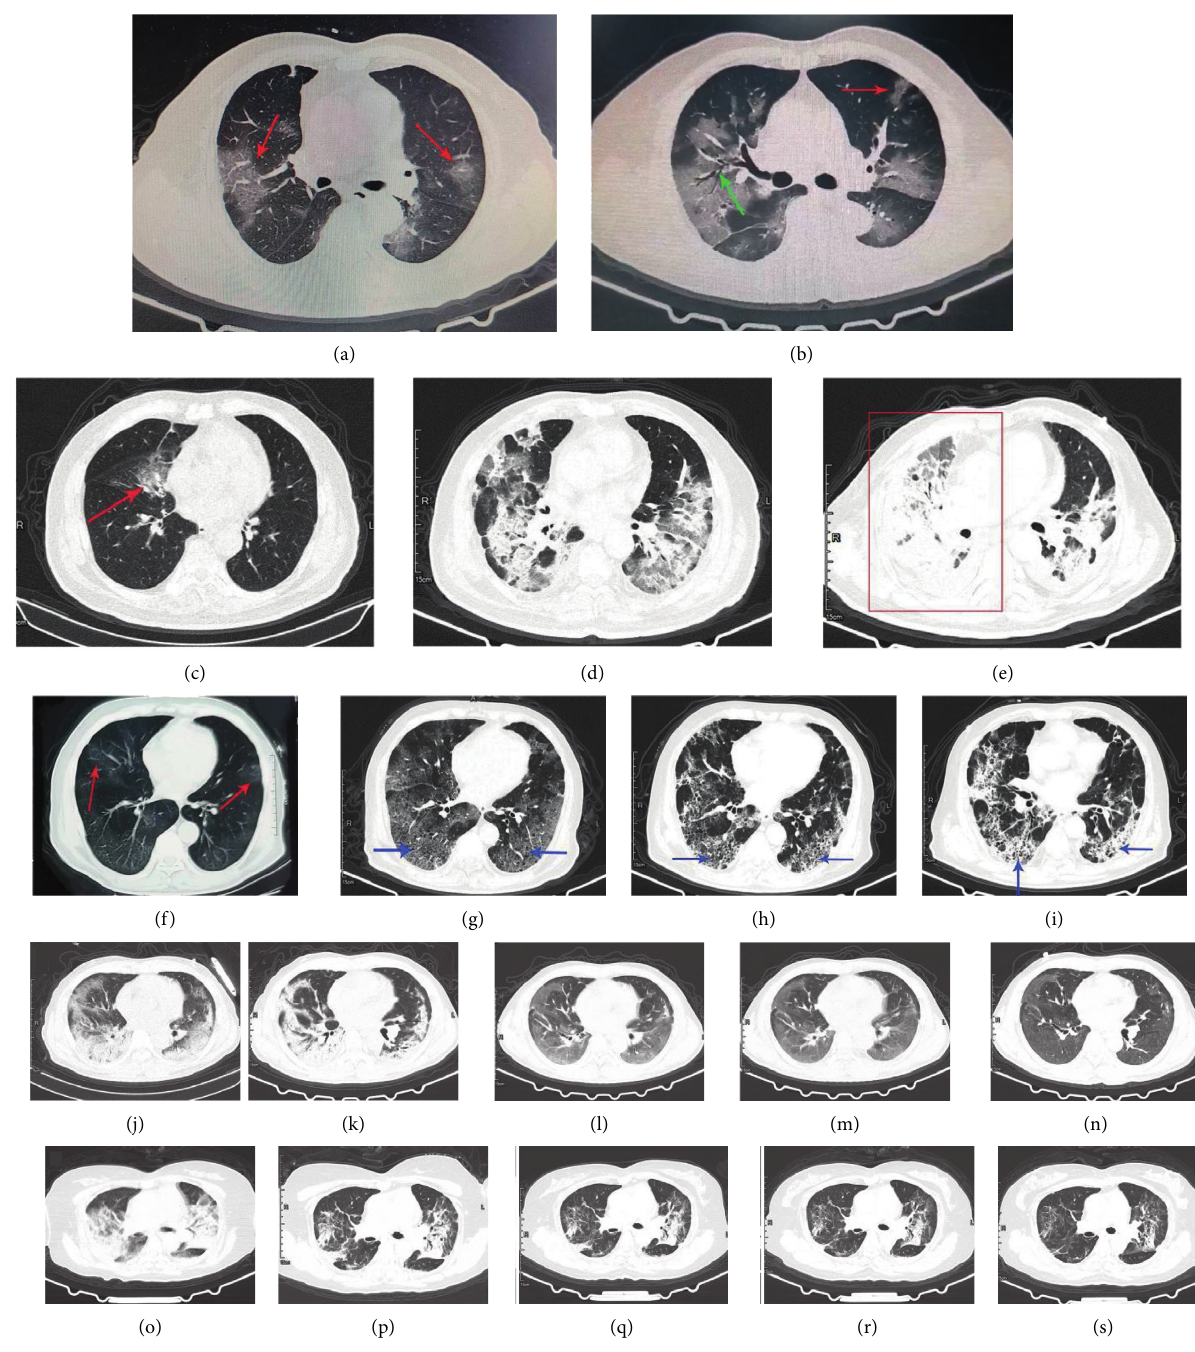
Figure 2: Chest computed tomographic images of COVID-19 patients. (a) and (b) show typical ground-glass opacities (marked by red arrow) and patchy shadows in both lungs of COVID-19 patients. The green arrow shows bronchial inflation sign. Case 1: (c), (d), and (e) are chest CT images of a 75-year-old dead man at the time of onset, the 14th day, and the 21st day after onset, respectively. The patient’s lung lesions became more and more serious, and the right lung finally presented a “white lung” like change (as shown in red rectangle). Case 2: (f), (g), (h), and (i) are chest CTimages of a 69-year-old severe male patient on admission, the 7th, 14th , and 21st days, respectively. The lesions showed fibrotic progression. The part pointed by the blue arrow shows “paving stone sign.” Case 3: (j), (k), (l), (m), and (n) are chest CT images of a 60-year-old severe male patient on admission, the 6th, 12th, 18th, and 24th days, respectively. The patient’s lung lesions gradually improved after comprehensive treatment. Case 4: (o), (p), (q), (r), and (s) are chest CTimages of a 58-year-old woman on admission, the 6th, 12th, 18th, and 26th days, respectively. The patient’s bilateral lung lesions gradually improved after symptomatic